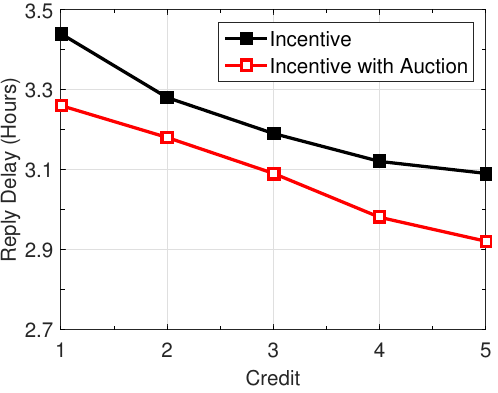
Figure 3. Impact of credit amount on reply